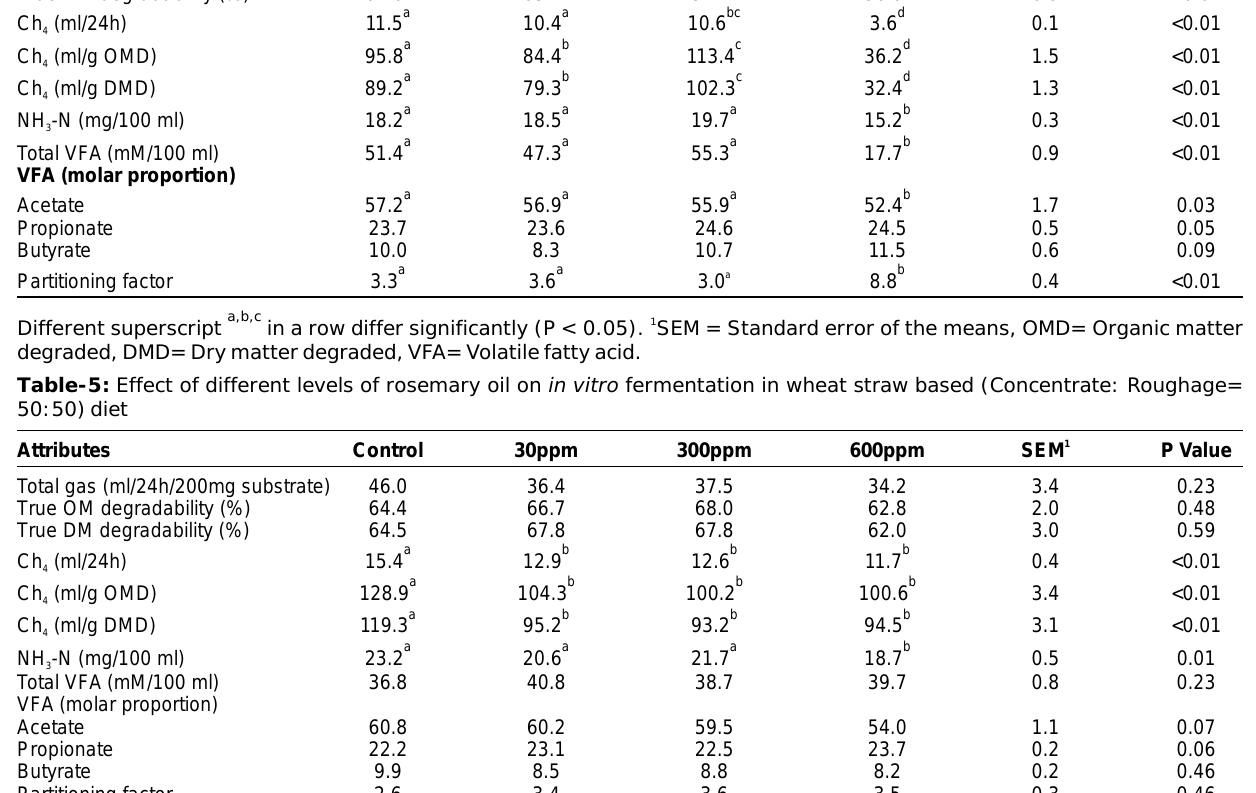
in a row differ significantly (P < 0.05). SEM = Standard error of the means, OMD= Organic matter degraded, DMD= Dry matter degraded, VFA= Volatile fatty acid.